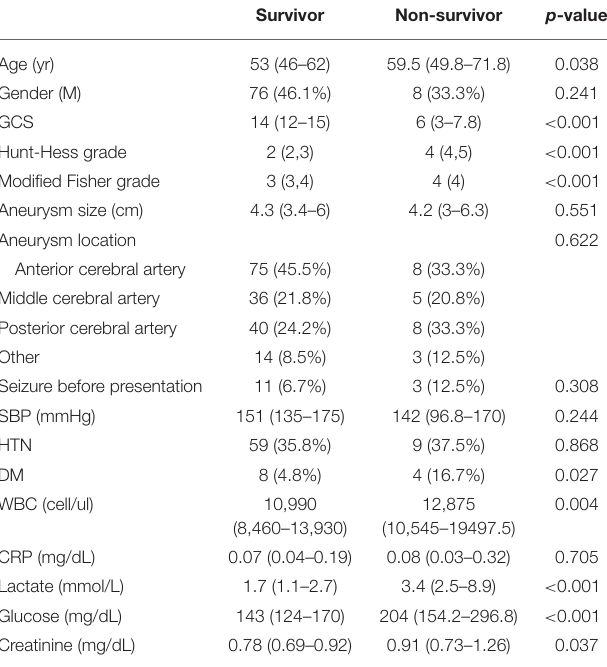
TABLE 1 | Baseline Characteristics of the